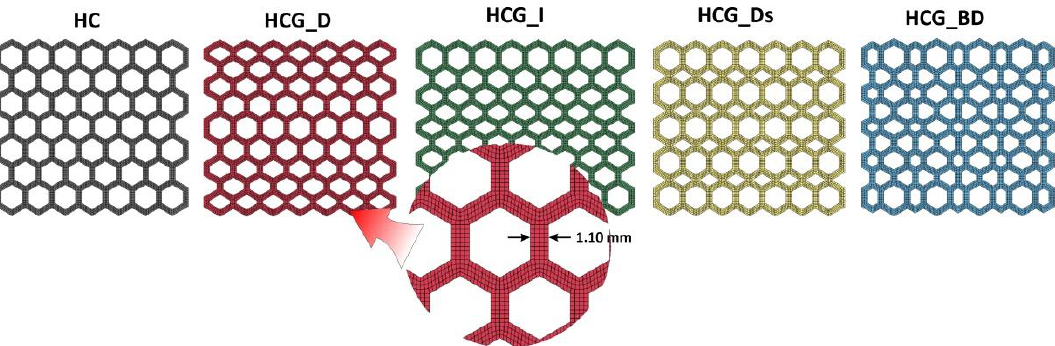
Figure 20. The main view of Finite Element (FE) models of developed structure specimens.